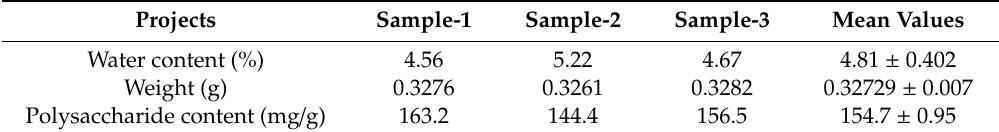
Table 7. Evaluation of the capsule by BS mucilage.